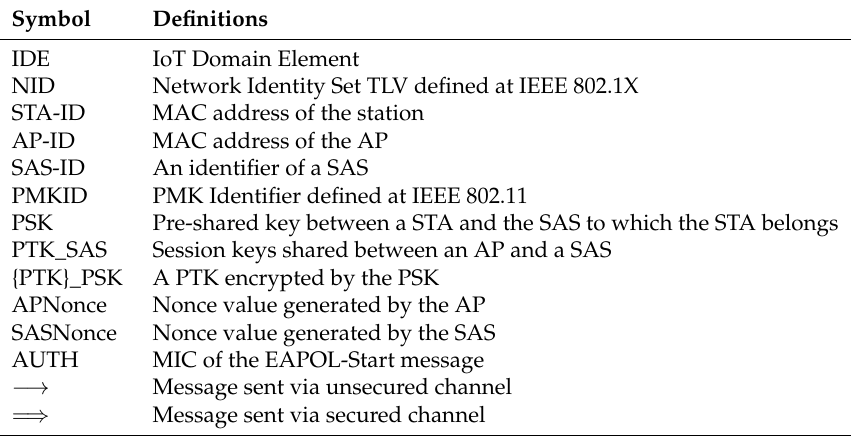
Table 2. Notations for the Figure